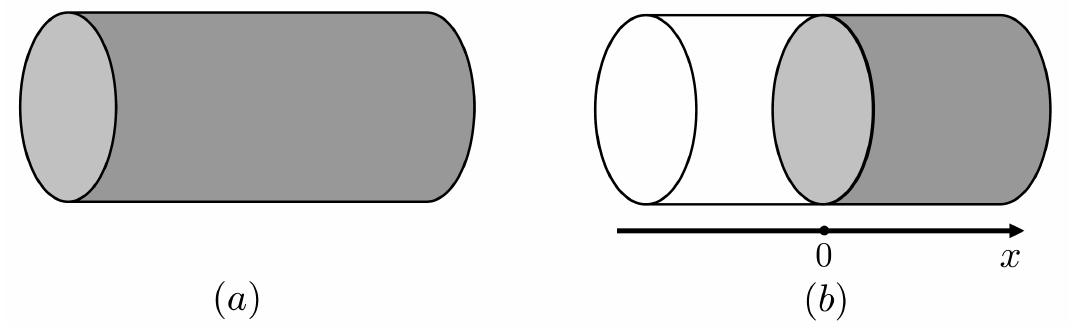
Figure 21: Simplified picture of a four-dimensional spacetime geometry with one unbounded coordinate −∞ < x < ∞ and three compact ones: ( a ) The topological insulators is filling the whole space; ( b ) It is located in x > 0 and separated from the empty space in x < 0 by a boundary at x =